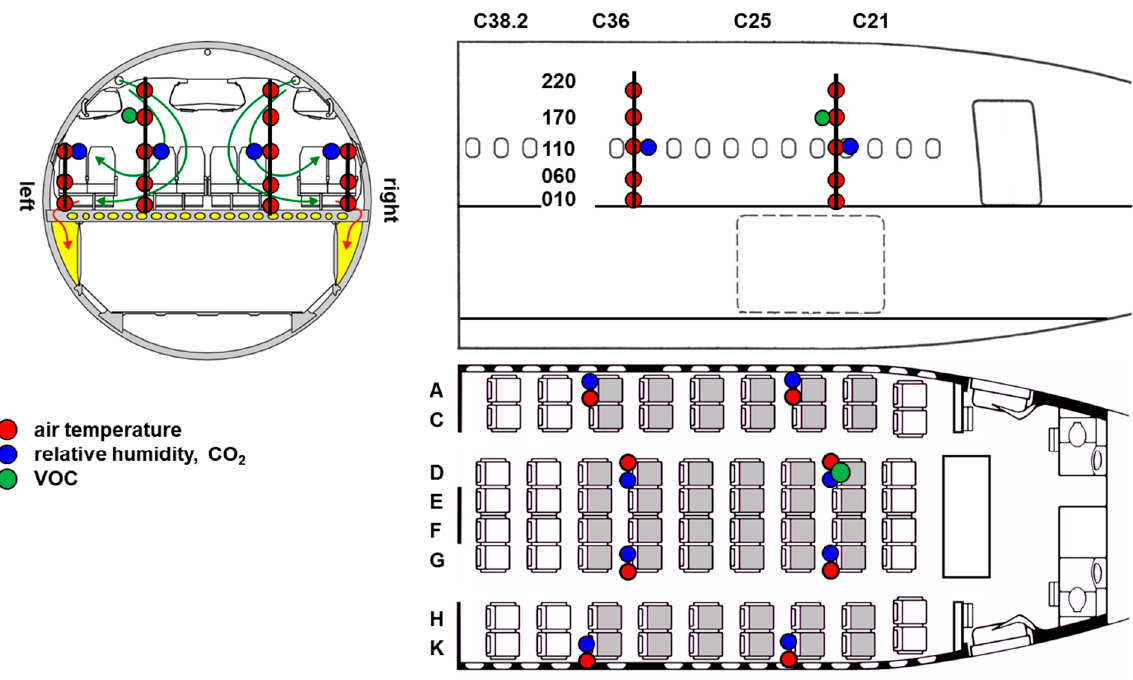
Figure 2. Cabin measurement